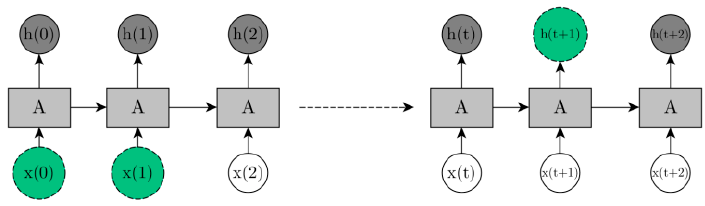
Figure 3. Long-term interdependencies in RNN models encompassing a connection of input vectors x (0) and x (1) to the hidden output vector h ( t + 1).